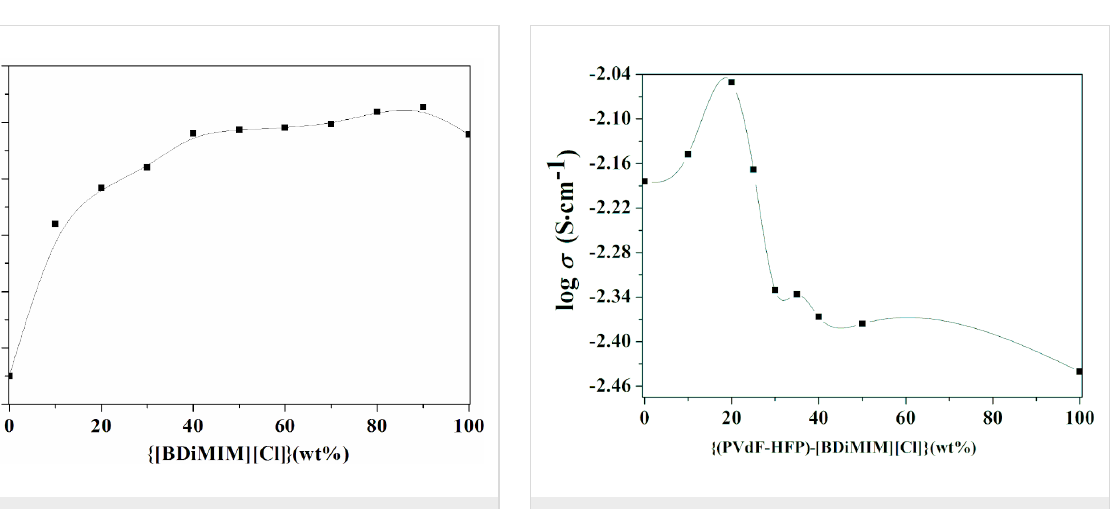
significantly increased and reached the maximum value of 6.5 × 10 − 3 S·cm − 1 at 60 wt % of the ionic liquid content.